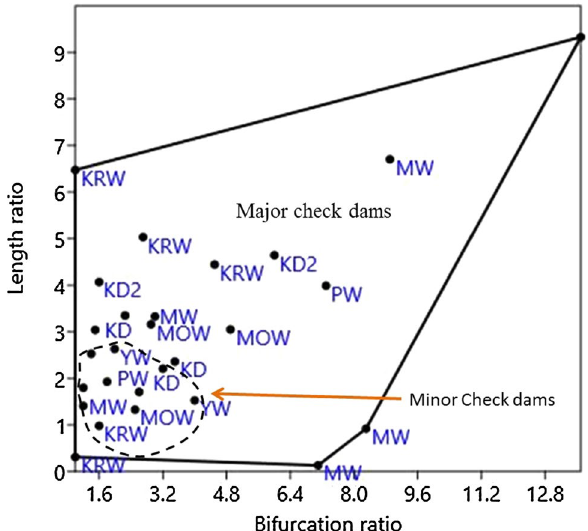
Fig. 6 Linear fit of RMA Regression of Bifurcation ratio versus Length ratio